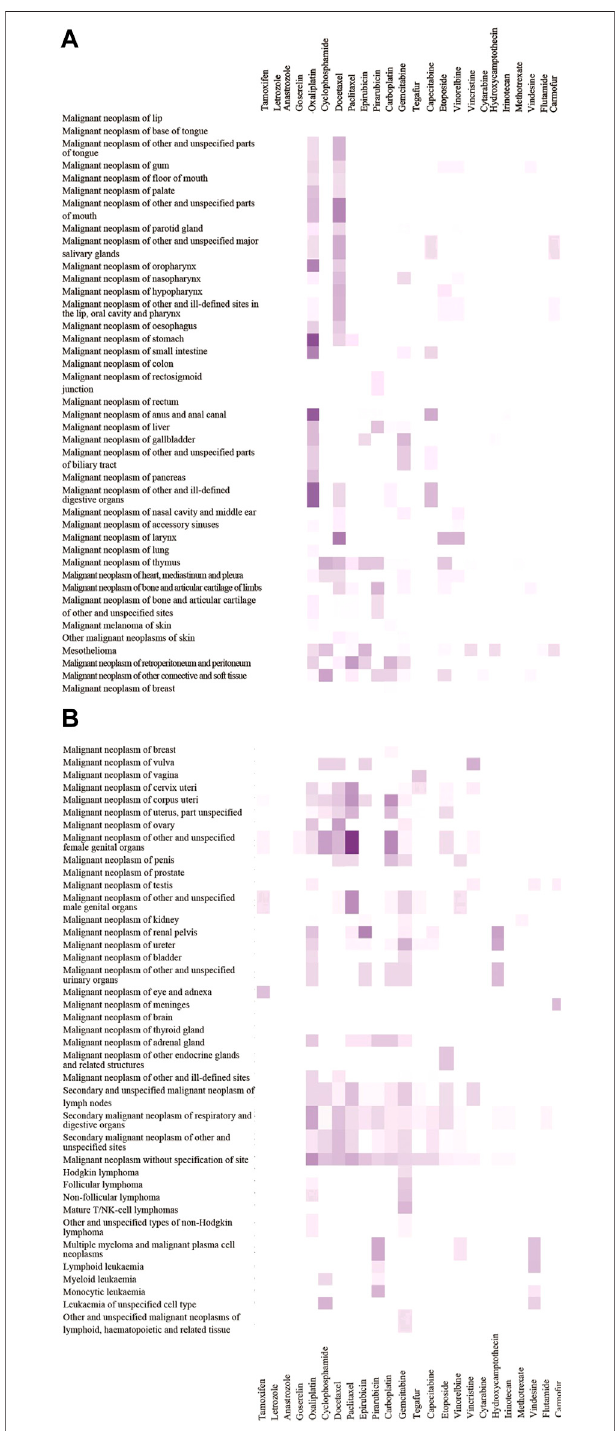
FIGURE 2 | OL use spectrum of 24 antineoplastic drugs in 77 malignancies.The depth of color scale represents the extent of OL use rates (range 0 – 40%). The malignancies are arranged from top to bottom according to ICD codes (C00-C96). Antineoplastic drugs are sorted in descending order from left to right based on total drug use